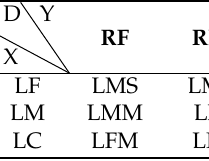
Figure 13. Visual studio 2008 operating interface.